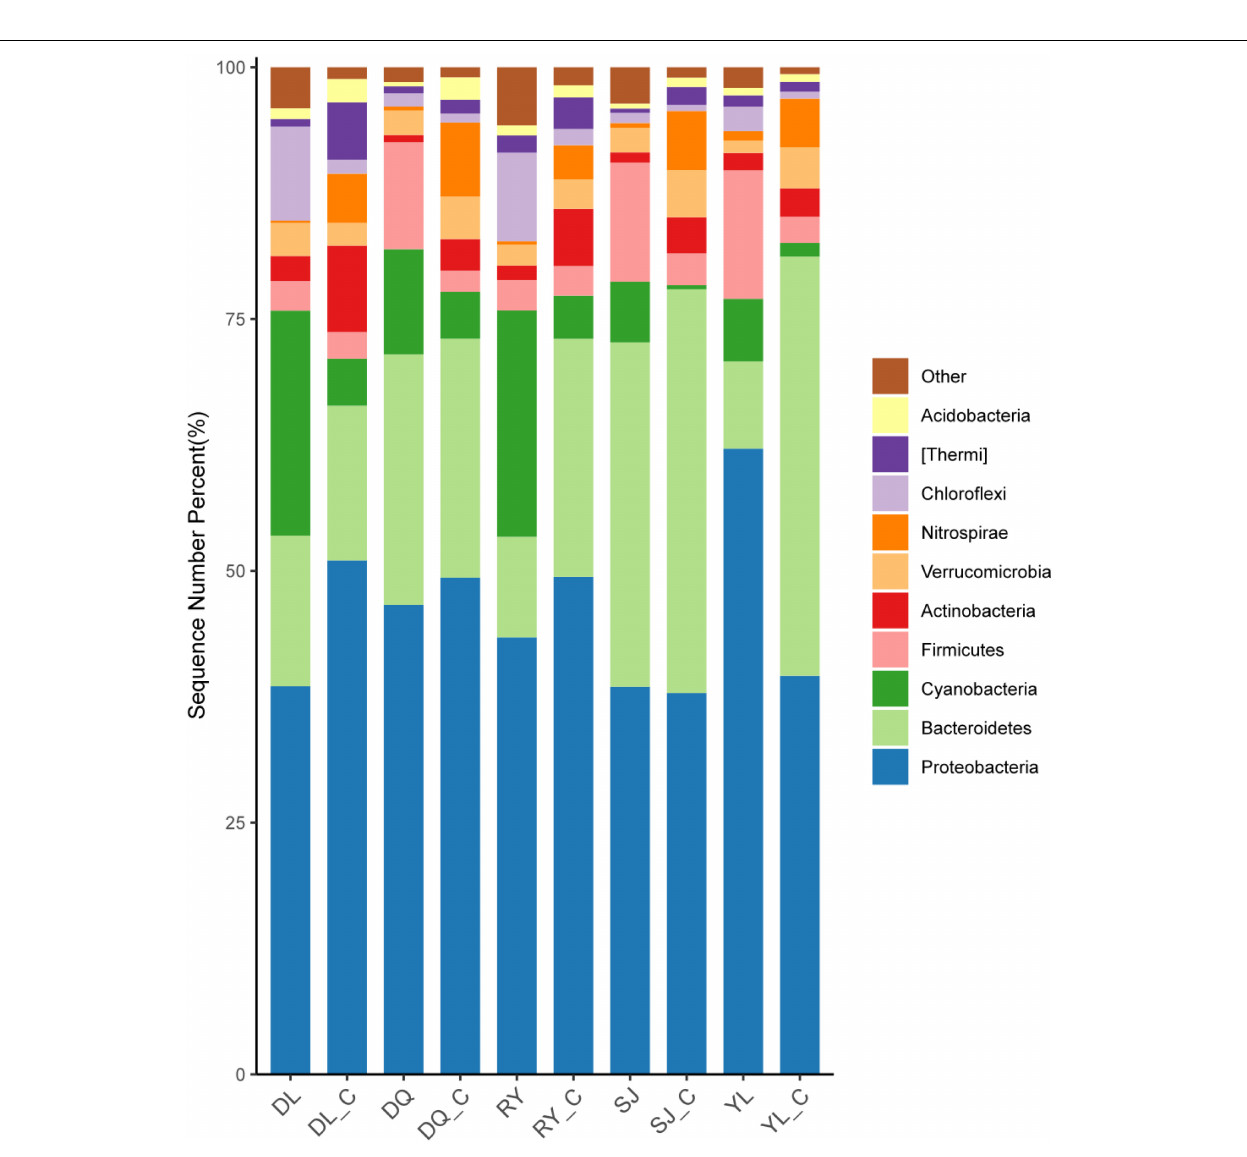
Frontiers in Microbiology |